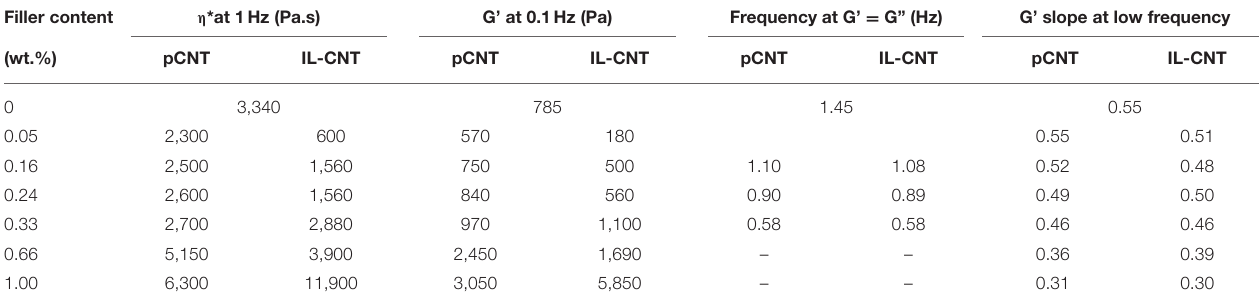
TABLE 1 | Main rheological parameters of PS/PBAT composites as a function of the filler content. Filler